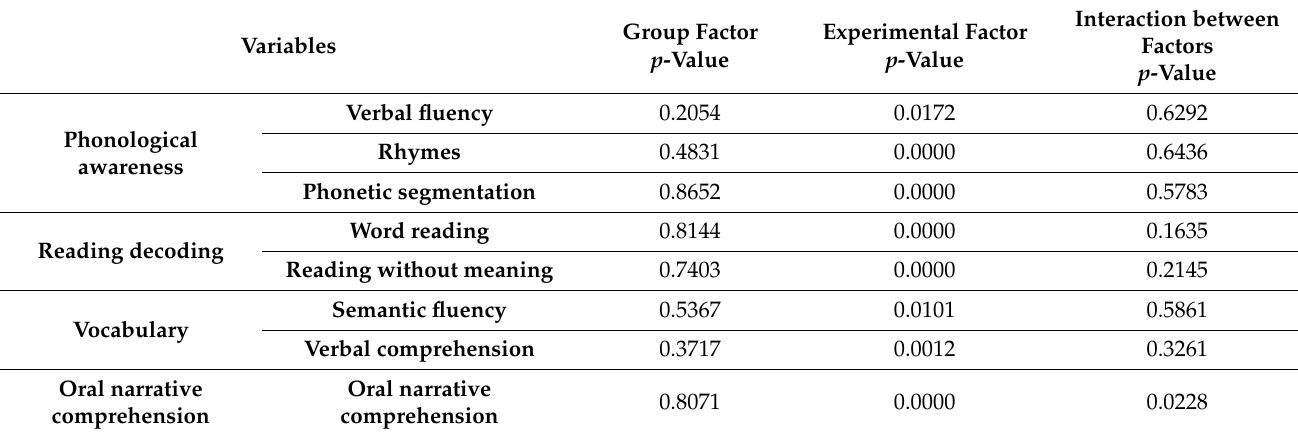
Table 2. Summary of p -values for the Type III sum of